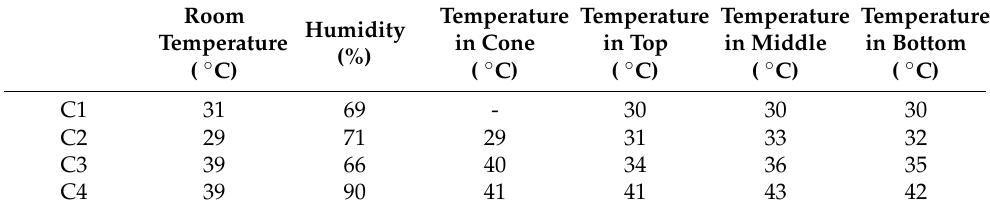
Table 1. Room temperature, humidity and initial temperatures in the top, middle, and bottom regions of the